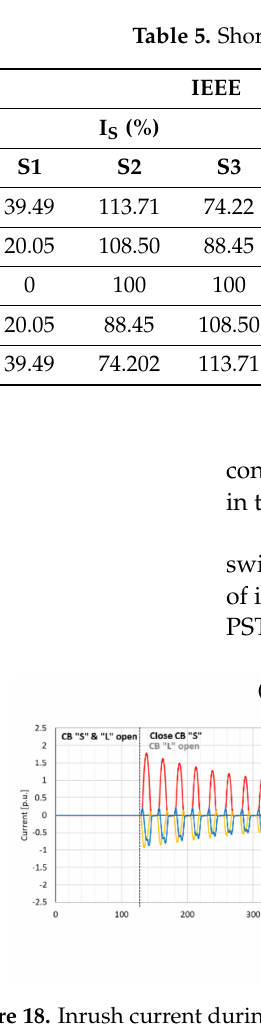
Figure 18. Inrush current during two step approach switching on the PST to the network for the tap position ( a ) 32R and ( b )